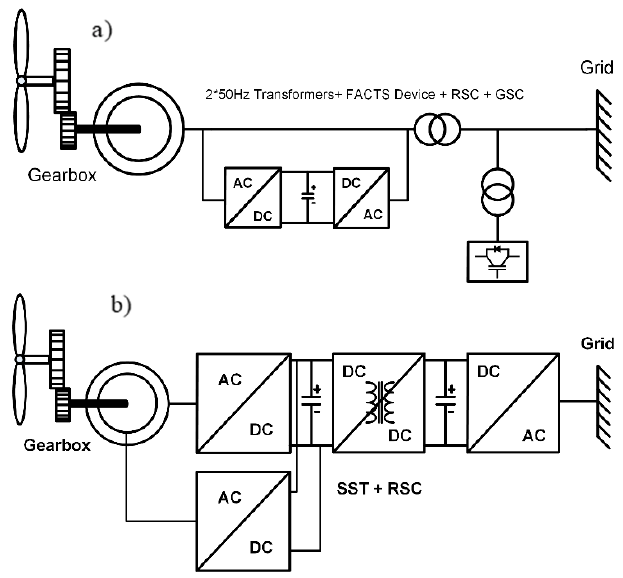
Figure 8. Integrating doubly fed induction generator (DFIG) to the grid: ( a ) typical; ( b ) using SSTs